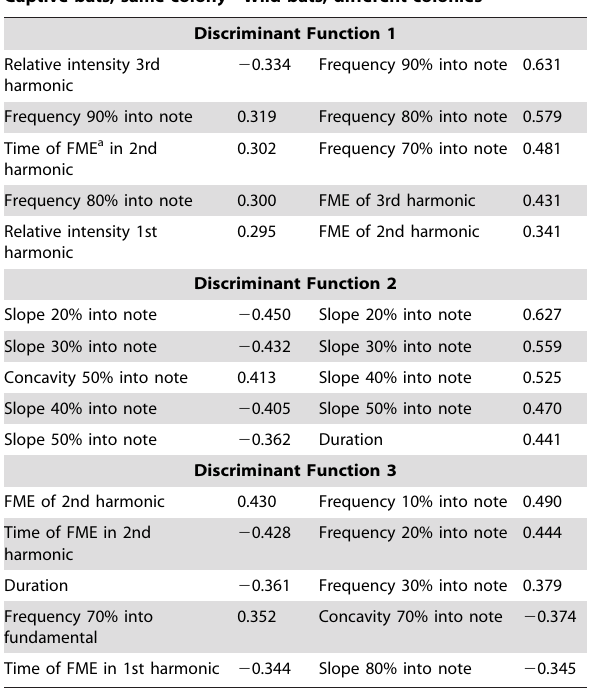
Table 5. Highest variable loadings for discriminant functions assigning notes to individual common vampire